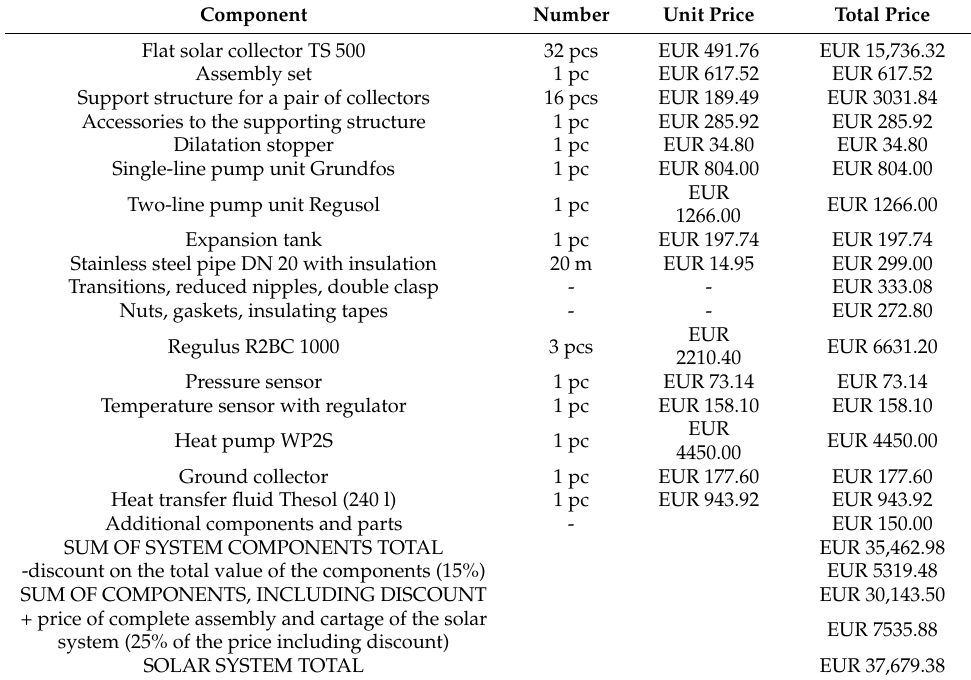
Table 1. The total cost of the proposed solar